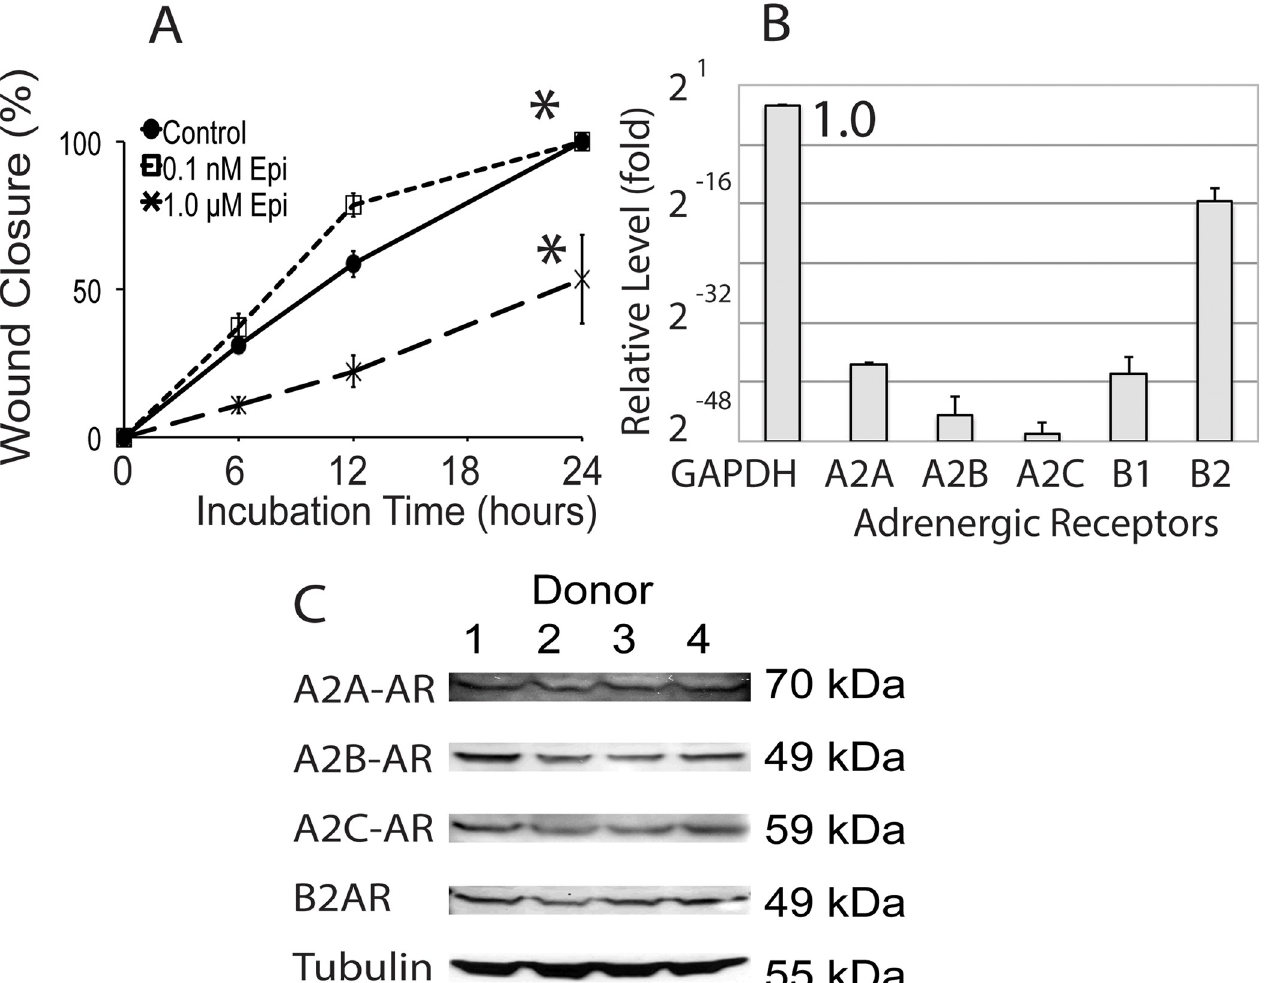
Fig 1. Migration patterns and expression of adrenergic receptors in human keratinocytes. (A) An increase in migration rate at 12 hours was observed in scratch assays with the keratinocytes treated with 0.1 nM (low concentration) of epinephrine compared to higher, 1 μ M concentration. (B) Quantitative RT-PCR (results normalized to GAPDH expression, set as 1.0; X-axis shown in log 2 scale) and (C) Western blotting was performed to detect the expression of adrenergic receptors in keratinocytes. In addition to the B2AR expression, alpha-AR subtypes are expressed in the keratinocytes at low levels. (N = 3 keratinocyte strains, mean +/- SE, � p <